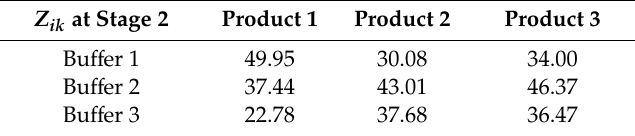
Table 5. The hedging points of the product types in the bu ff ers at stage 2.